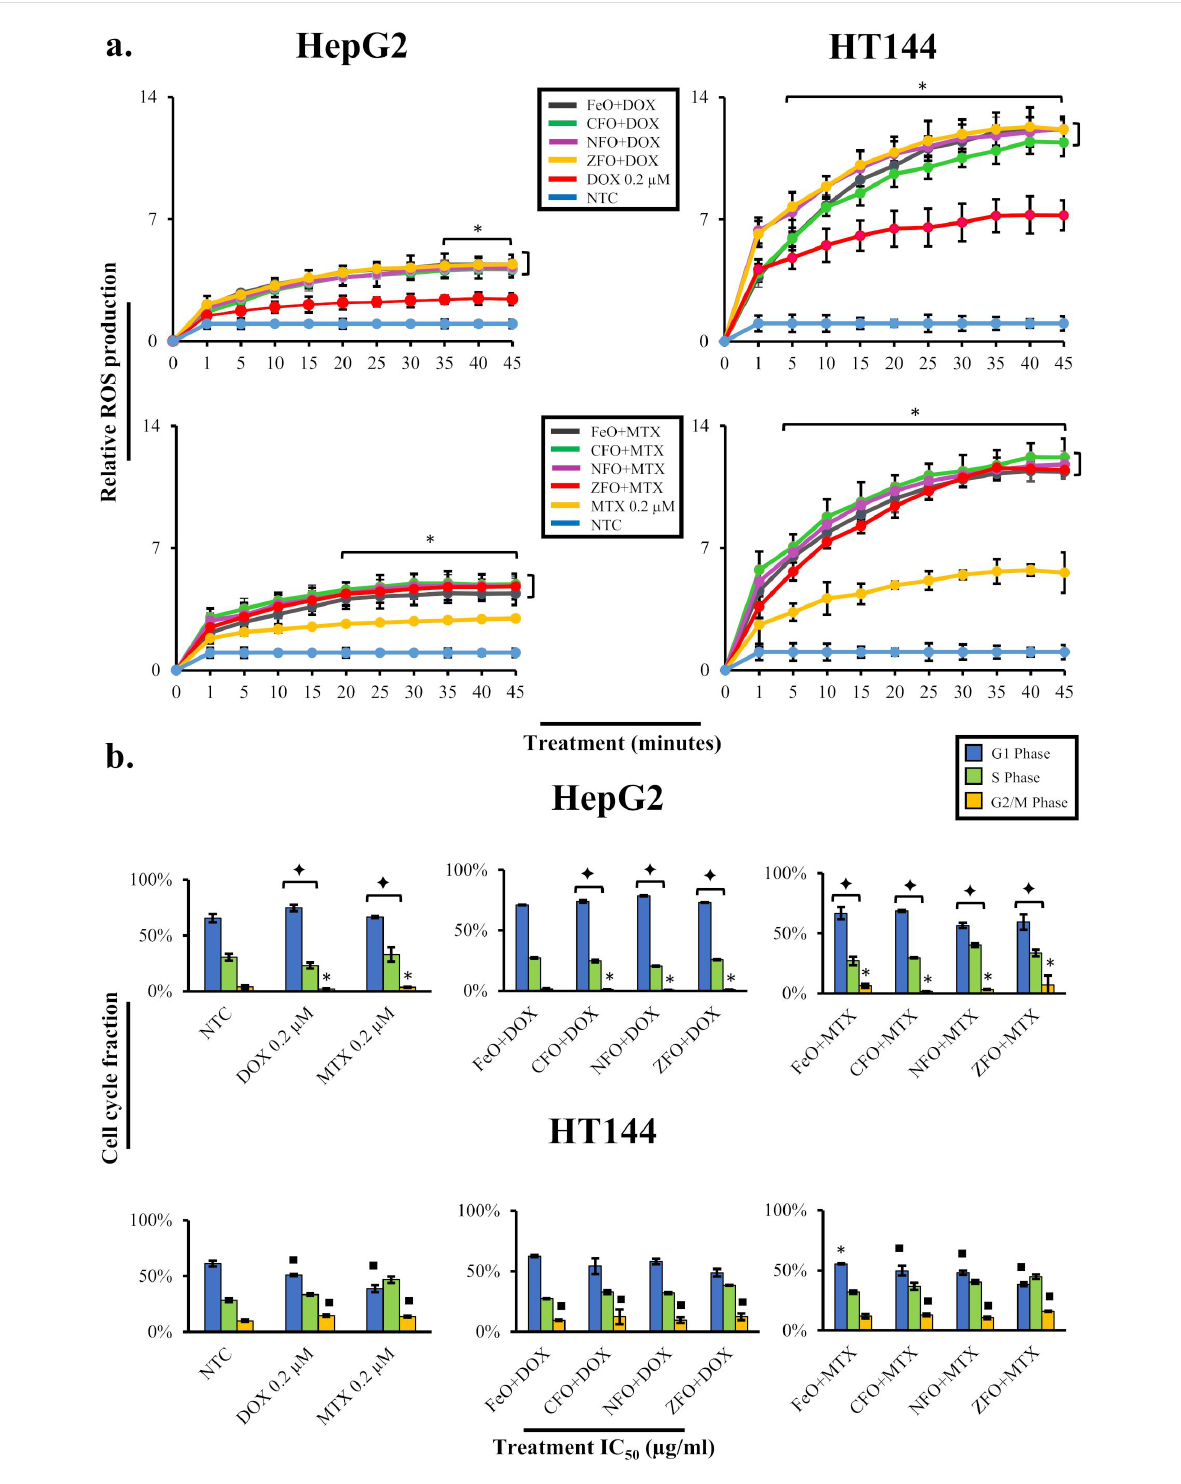
Figure 6: (a) Intracellular ROS generation in HepG2 and HT144 cells upon treatment with drug-loaded (DOX and MTX) MFe 2 O 4 (M = Fe, Co, Ni, Zn) NPs for 0–45 min at IC 50 doses. Free drugs (DOX and MTX, 0.2 µM each) and NTC were included as controls. ROS generation in cells was deter- mined relative to NTC. Data was represented as mean ± SD of experimental triplicates. p < 0.05 (one asterisk), paired two-tailed t -test when com- pared to NTC. (b) Effect of drug-loaded MFe 2 O 4 NPs on cell cycle progression in HepG2 and HT144 cells determined by flow cytometry. Cells were exposed to IC 50 doses of NPs for 24 h. Untreated cells and free drugs (DOX and MTX, 0.2 µM) were included as controls. p < 0.05 (one asterisk), p < 0.01 (black square symbol), p < 0.005 (black diamond symbol), paired two-tailed t -test when compared to